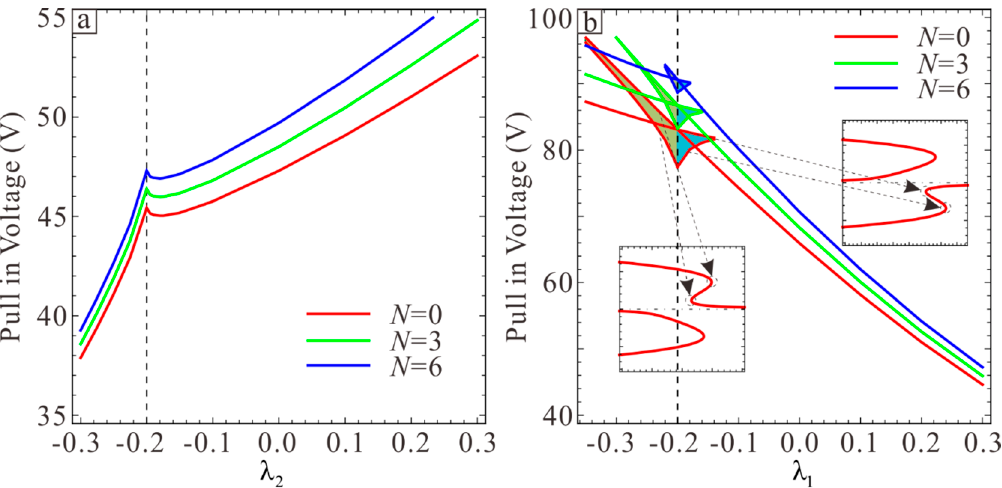
Figure 8. The influence of section parameters on pull-in voltage under different residual stresses. ( a ) The influence of λ 2 on pull-in voltage when λ 1 = 0.2. ( b ) The influence of λ 1 on pull-in voltage when λ 2 = 0.2